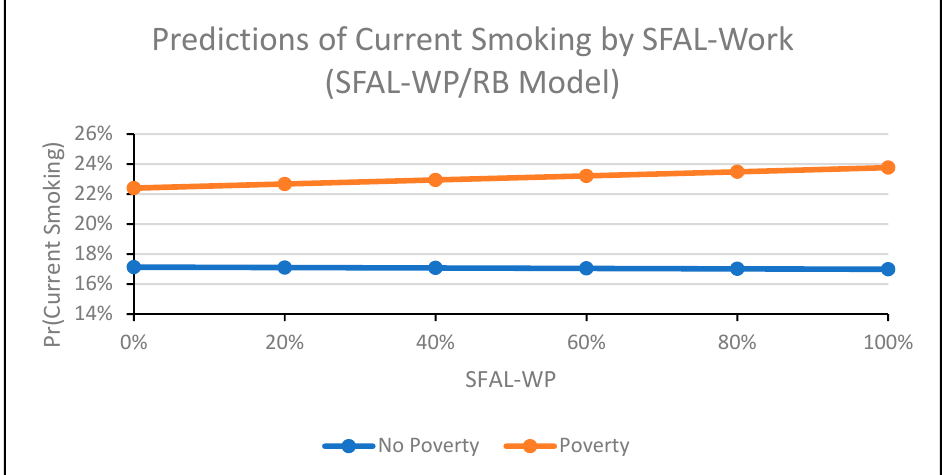
Figure 2. This figure depicts the probability of individual-level adult current smoking in the 1985 − 2015 supplements to the U.S. Current Population Survey by state tobacco control funding (TCF), stratified by individual-level poverty status (living <138% of poverty line versus living ≥ 138% of poverty line). Smoke-free law coverage is modeled as percent of state population covered by workplace laws (SFAL-WP) and percent covered by restaurant and/or bar laws (SFAL-RB), and the figure excludes participants with missing values for variables of interest. The figure was produced using the “margins” command in Stata.